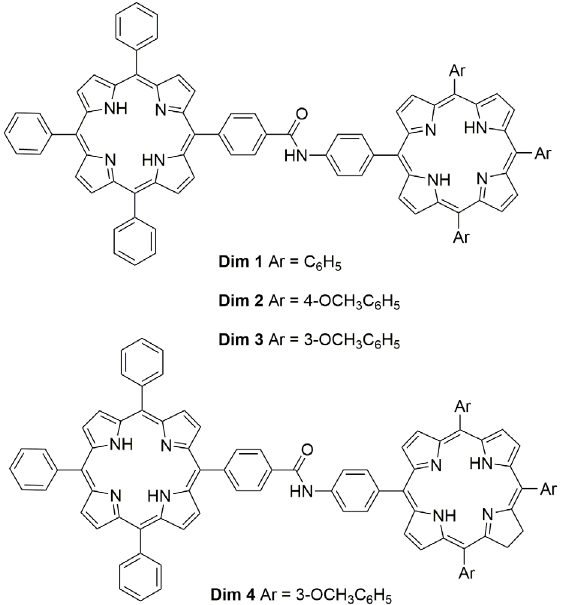
Figure 12 - Structures of dimers Dim 1-4 linked by amide